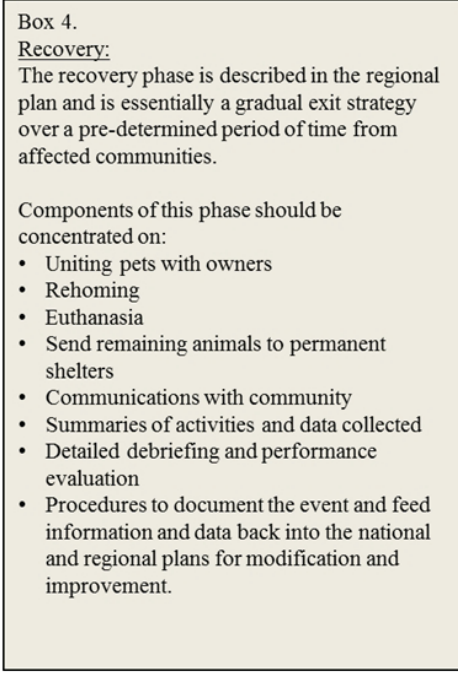
Figure 4. Description of the recovery period following the acute disaster phase with examples of typical